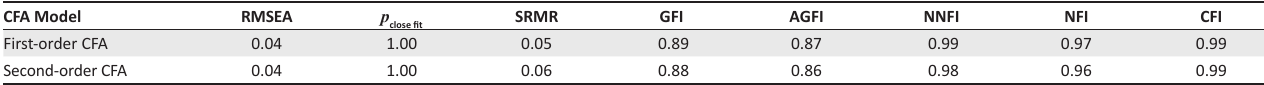
TABLE 4: Goodness-of-fit indices obtained for the measurement and structural models. CFA Model